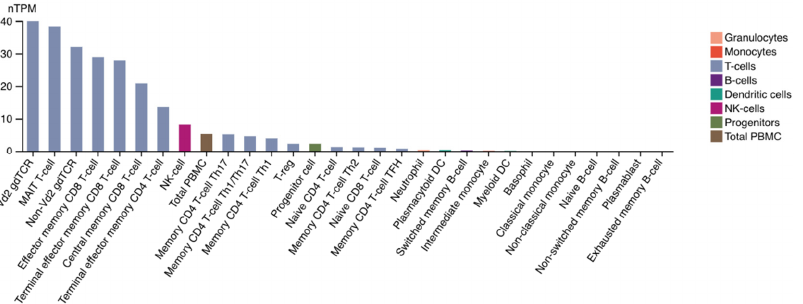
Figure 2. Blood cell type expression overview shows RNA-seq data generated by The Cancer Genome Atlas (TCGA). Color-coding is based on blood cell type lineages, including B-cells, T cells, NK-cells, monocytes, granulocytes and dendritic cells as well as total PBMC. Image credit: Human Protein Atlas, www.proteinatlas.org (accessed on 8 August 2022). Image available at the following URL: v21.proteinatlas.org/ENSG00000089692-LAG3/immune+cell#top.